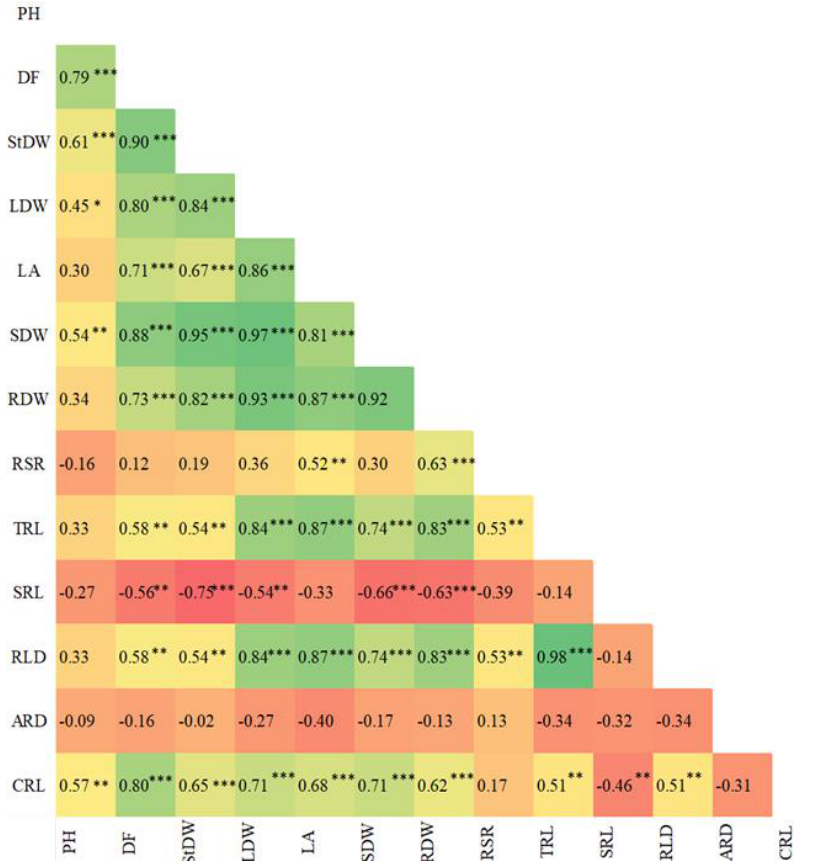
Figure 6. Pearson’s correlations (r) for 13 root and shoot traits in soybean genotypes. *, **, and *** indicate significant correlations at p < 0.05, p < 0.01, and p < 0.001, respectively. PH = plant height, DF = days to first flower, StDW = stem dry weight, LDW = leaf dry weight, LA = leaf area, SDW = shoot dry weight, RDW = root dry weight, RSR = root: shoot ratio, TRL = total root length, SRL = specific root length, RLD = root-length density, ARD = average root diameter, CRL = cumulative root length.